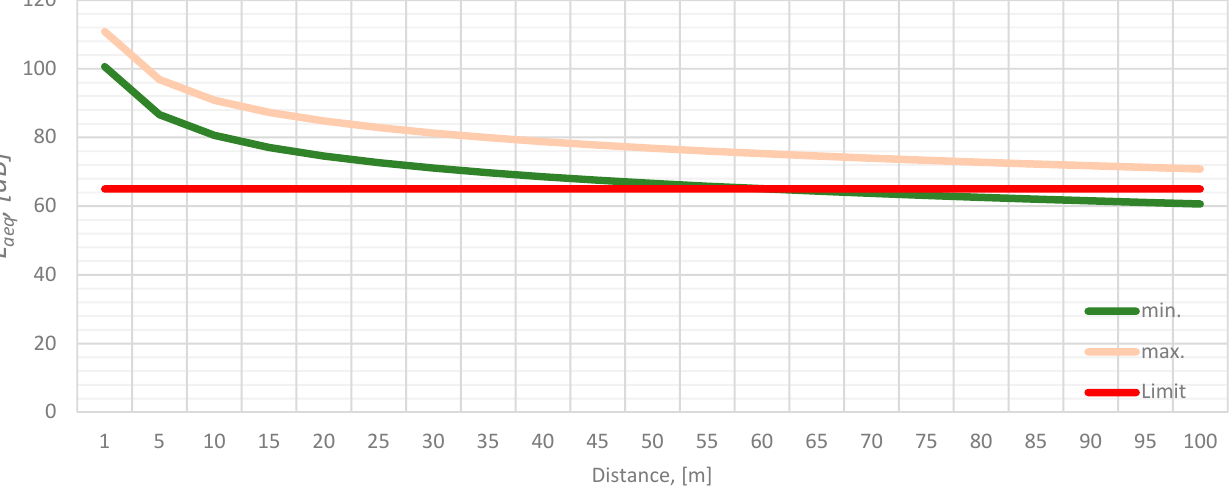
Figure 9. Sound level distribution according to distance from the source.